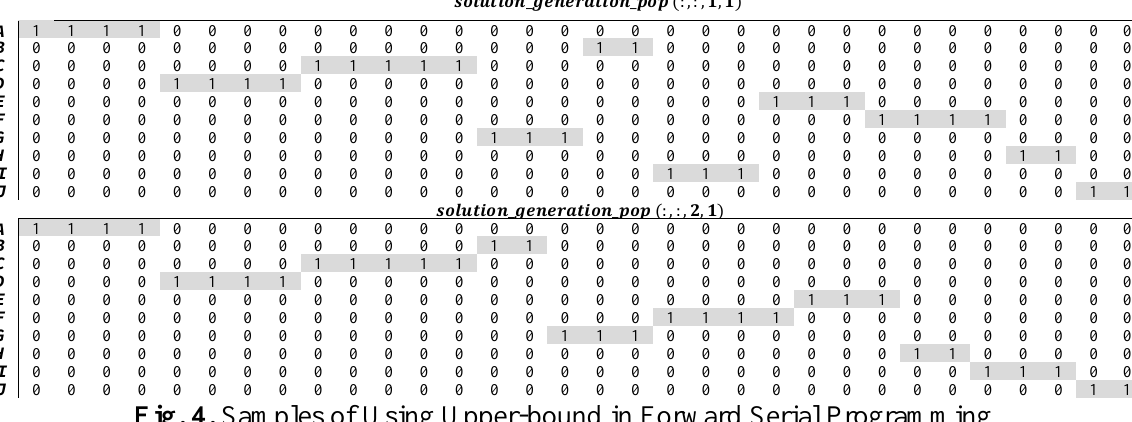
Fig. 4. Samples of Using Upper-bound in Forward Serial